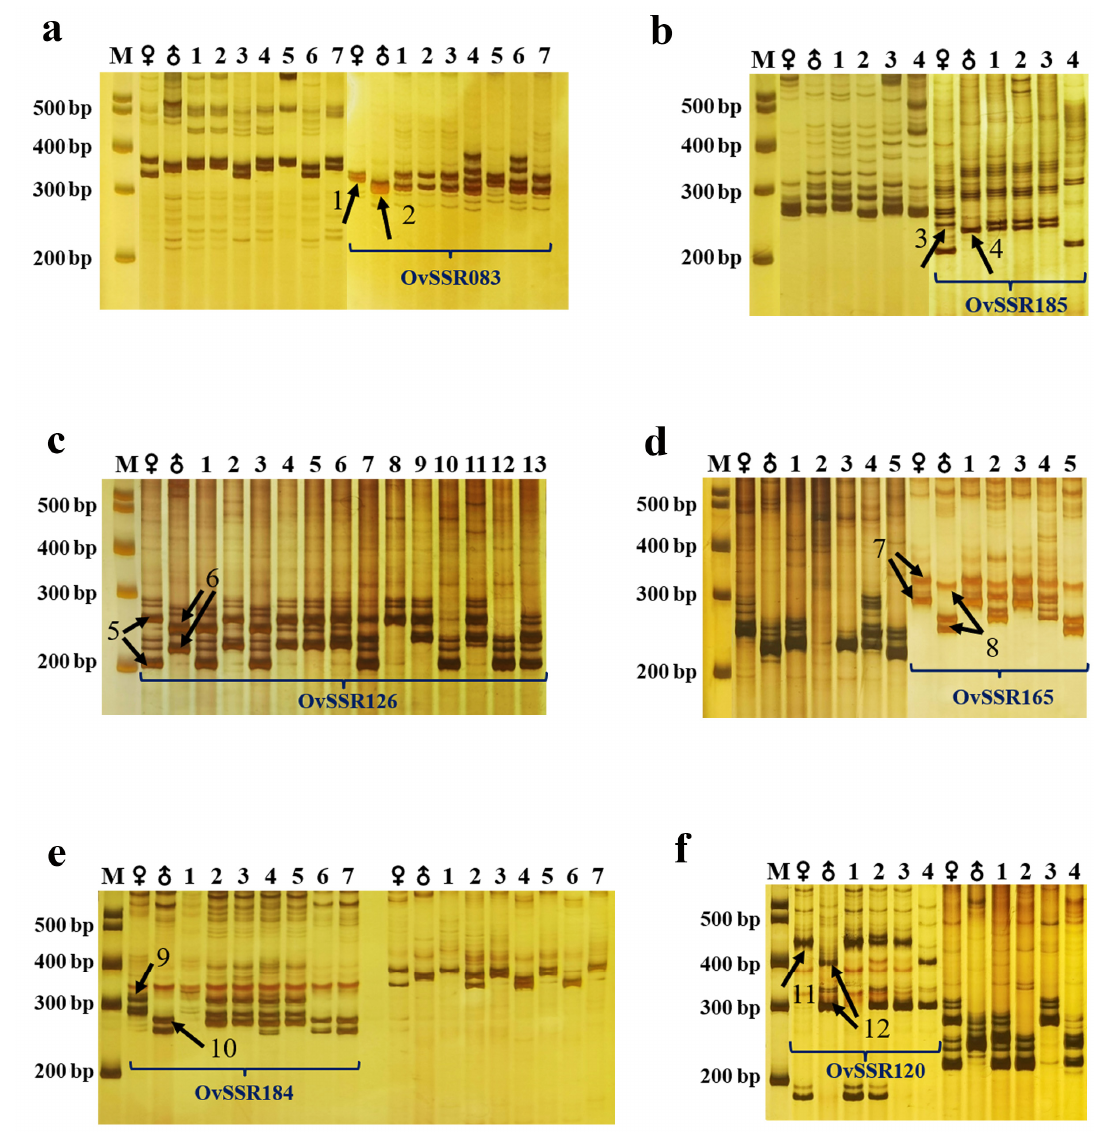
Figure 5. Genotyping of the F 1 progeny of six hybrid combinations using codominant SSR markers. ( a – f ) Genotyping F 1 lines of combination 1 (Omh × Ov) using the OvSSR083 marker ( a ), combination 2 (Ovv × Ovh) using the OvSSR185 marker ( b ), combination 3 (Omh × Ovc) using the OvSSR126 marker ( c ), combination 4 (Ovhs × Ovs) using the OvSSR165 marker ( d ), combination 5 (Ovv × Ovs) using the OvSSR184 marker ( e ), and combination 6 (Omh × Ovs) using the OvSSR120 marker ( f ). M, DNA Marker; ♀ , female parent (indicated on the left in each combination); ♂ , male parent (indicated on the right in each combination). Numbers represent F 1 lines. Arrows 1, 3, 5, 7, 9, and 11 indicate characteristic bands of the female parents. Arrows 2, 4, 6, 8, 10, and 12 represent characteristic bands of the male parents.